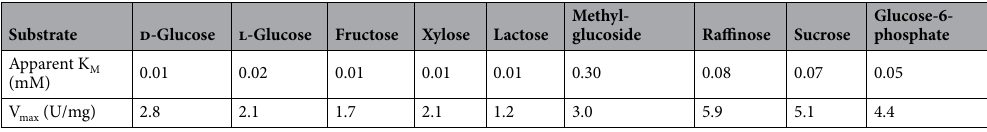
Table 1. Michaelis–Menten parameters of the activity of GOx/CTAB@Au on various saccharides.